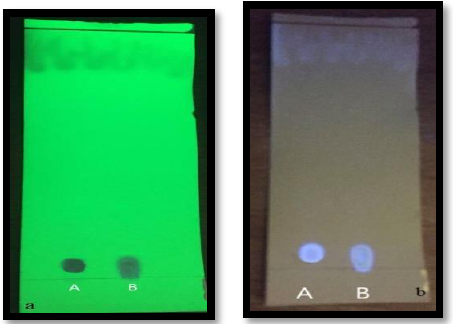
Figure 9. Thin- layer chromatography for chlorogenic acid standard A and isolated chlorogenic acid B, on Gf 254 silica gel detection under uv light a: at 254 nm and b: 366 nm .